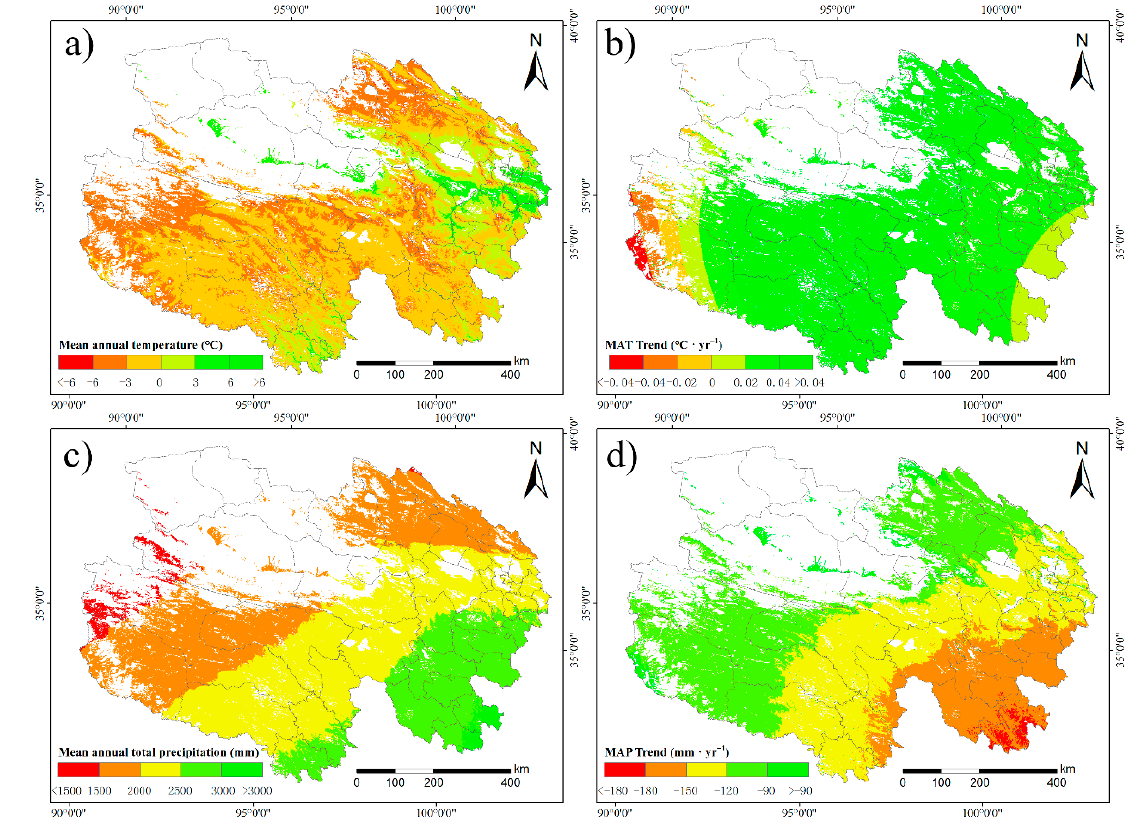
Figure 2. Spatiotemporal patterns of precipitation and temperature in alpine grassland in Qinghai Province from 2005 to 2018. ( a ) Mean annual temperature (MAT), ( b ) change trend of MAT, ( c ) mean annual total precipitation (MAP), and ( d ) change trend of MAP.